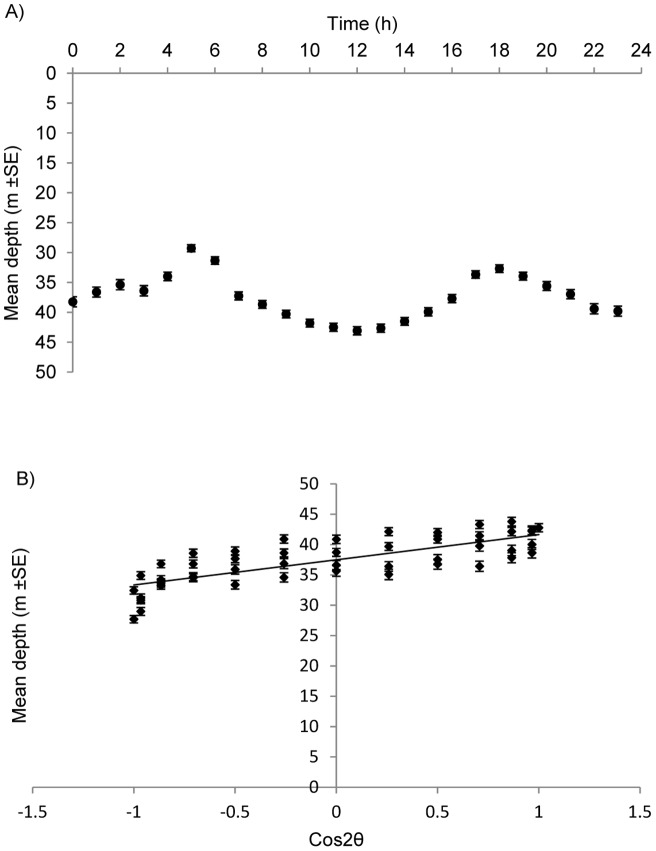
Daily pattern of vertical movements by grey reef sharks in Palau.A) Mean hourly depth of grey reef sharks combined. B) Linear regression of mean depth of grey reef sharks combined as a function of Cos2θ-transformed hours. y = 4.15x + 37.49, R2 = 0.59.